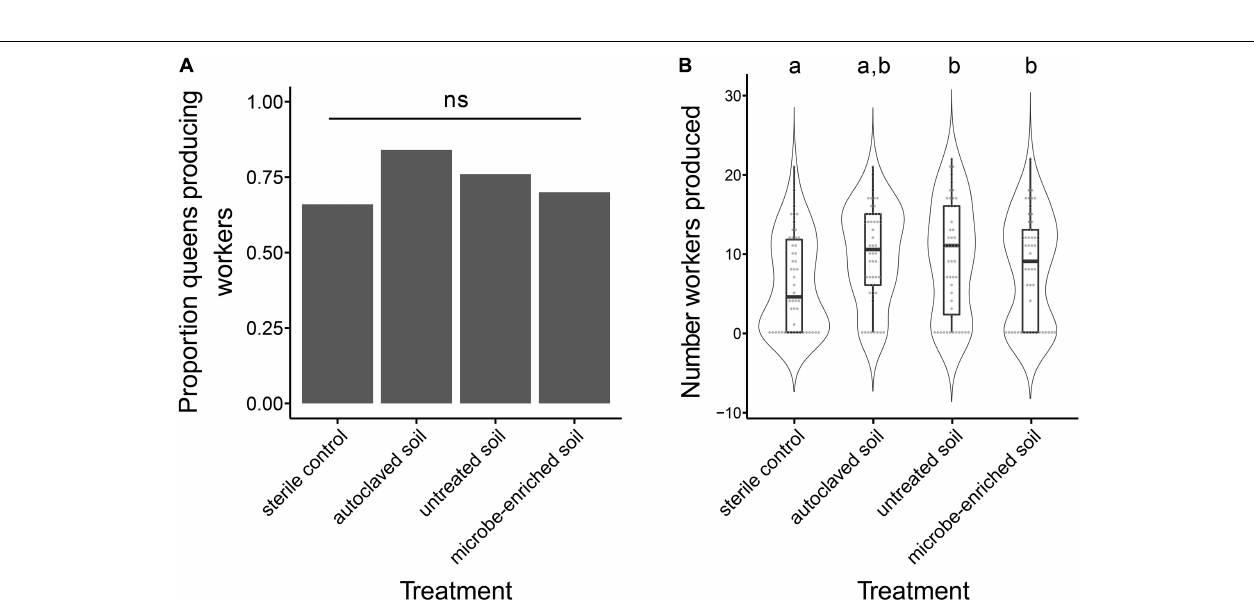
FIGURE 1 | Survival of queens founding a colony under different environmental conditions over the complete experimental period (gray solid line: sterile control, dotted line: autoclaved soil, dashed line: untreated soil, solid black line: microbe-enriched soil), i.e., from the start of the founding experiment until the end of the experiment, with the time of hibernation (day 83 to 221–225 depending upon treatment, see materials and methods) indicated by the gray rectangle.